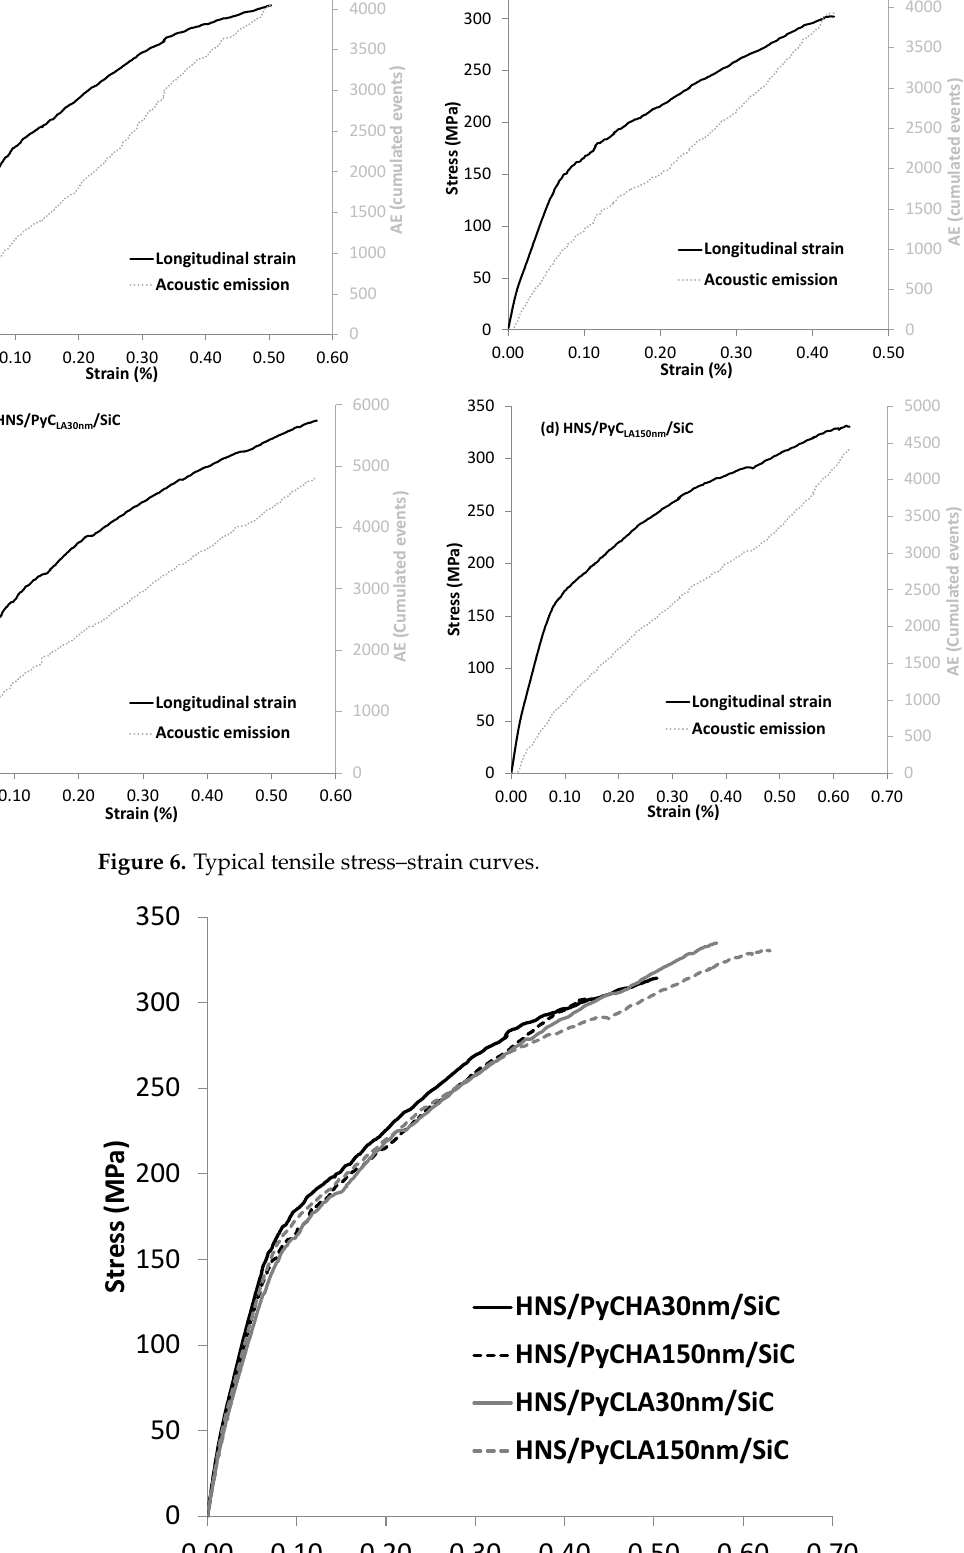
Table 6. Mechanical characteristics mean values of all SiC/SiC specimen types. () standard deviation.